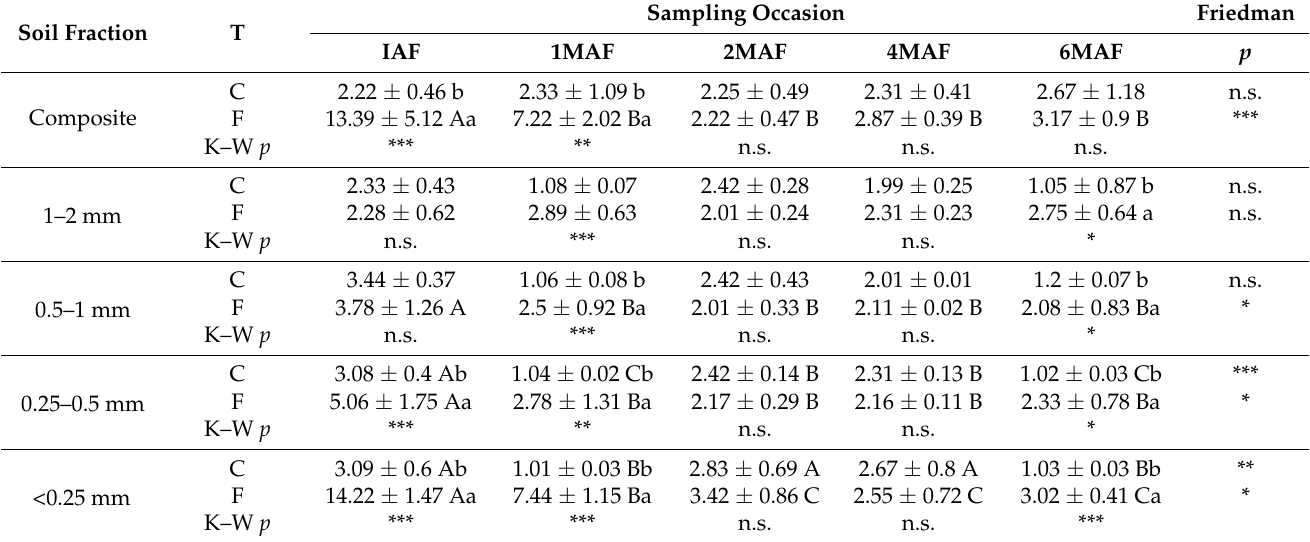
Table 1. Soil water repellency measured with water drop penetration time (s) on different soil fractions in control (C) and fire (F) treatments (T) during the studied period (IAF, immediately after fire; MAF, months after fire) (mean ± standard deviation). Different letters indicate significant differences between sampling dates (uppercase letters) and treatments (lowercase letters). Kruskal–Wallis (K–W) (* p < 0.05, ** p < 0.01, *** p < 0.001, and n.s. non-significant at p < 0.05) results are shown for each comparison between treatments, and Friedman ANOVA between sampling dates.